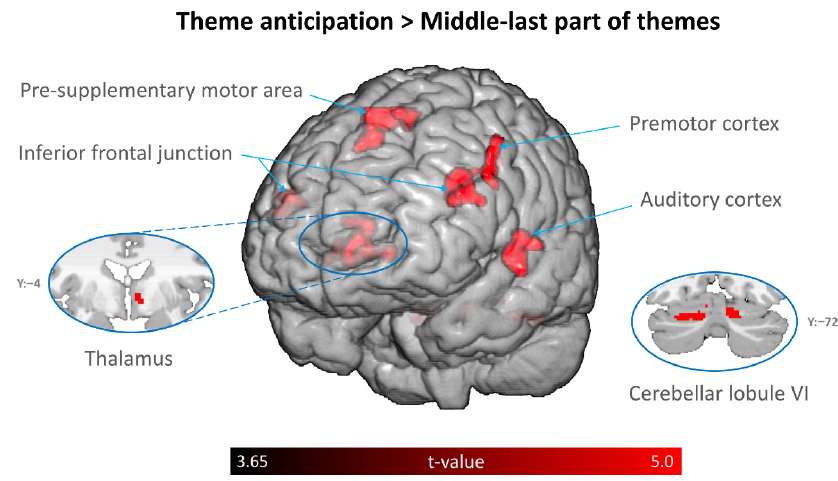
Figure 3. Group-level activation map for the contrast of theme anticipation minus middle-last part of themes.